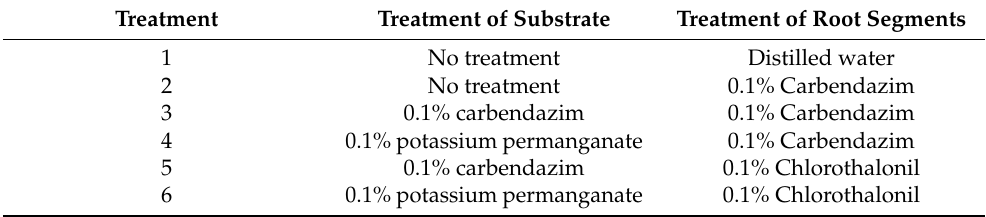
Table 1. Treatment of substrate and root segments with different disinfecting